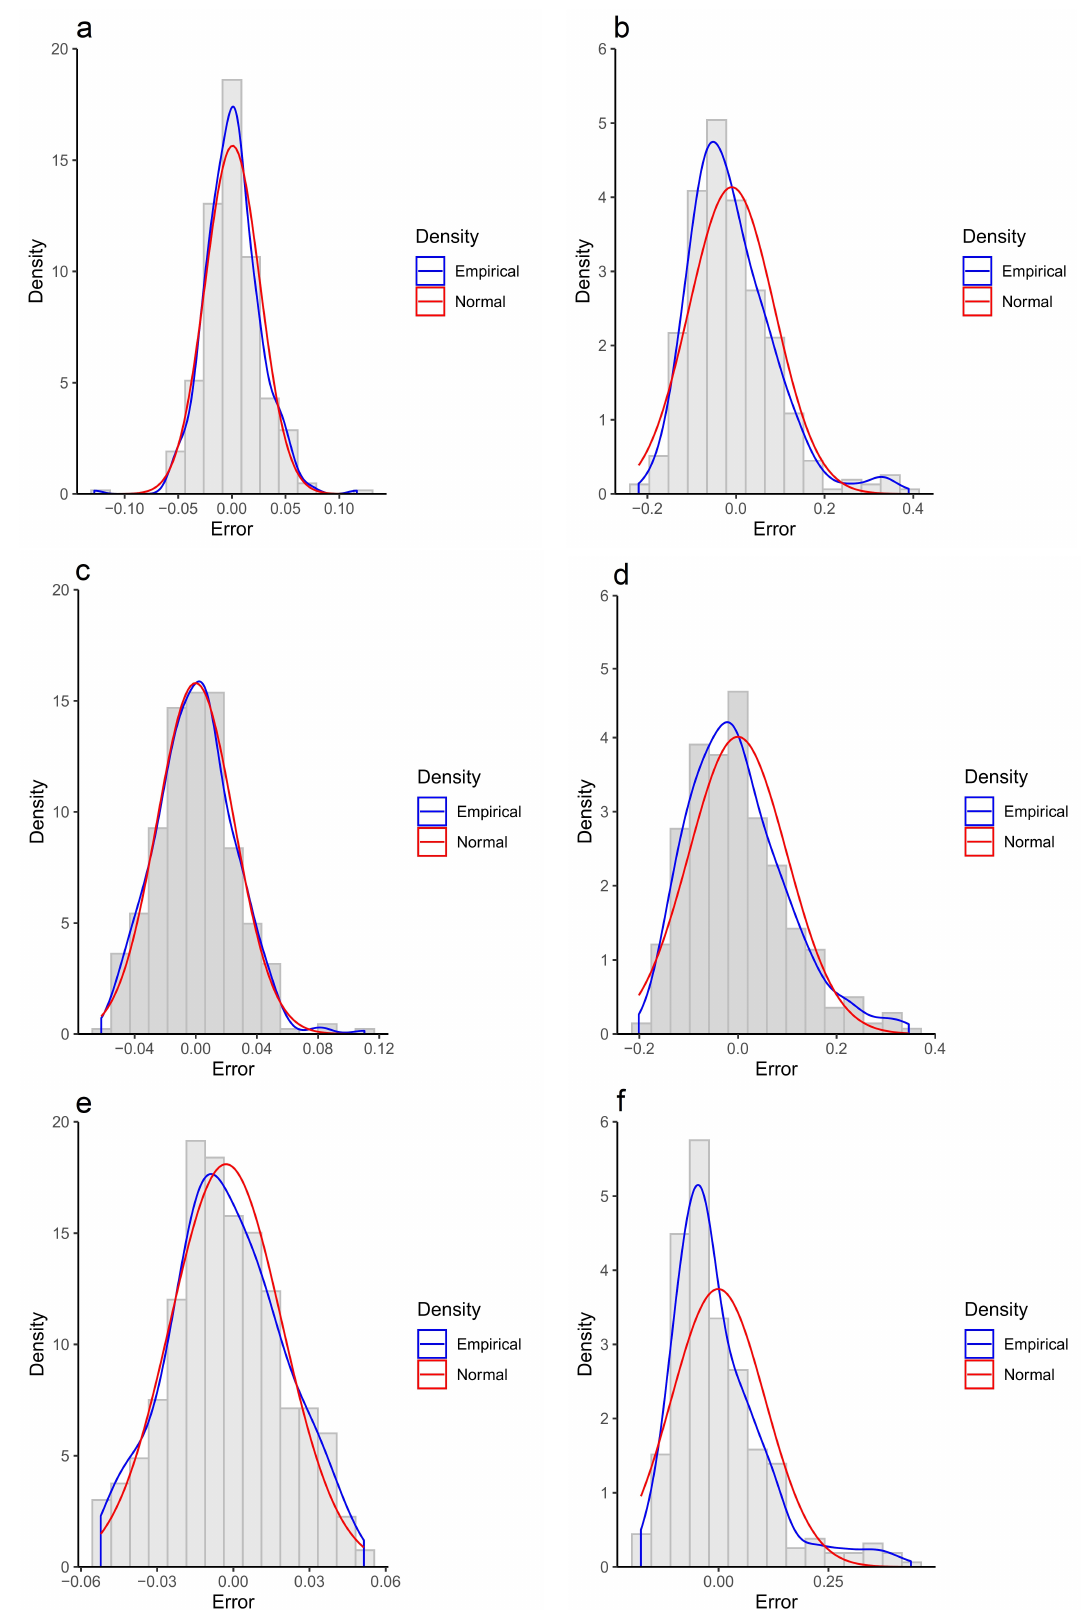
Figure 9. Empirical distribution of error values versus the normal distribution for the SVR and ANN based emulators. ( a ) SVR error distribution-CS1, ( b ) ANN error distribution-CS1, ( c ) SVR error distribution-CS2, ( d ) ANN error distribution-CS2, ( e ) SVR error distribution-CS3, ( f ) ANN error distribution-CS3